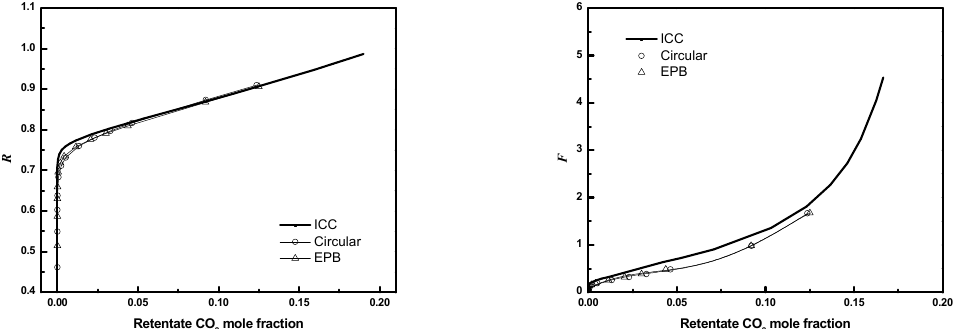
Figure 19. R or F as a function of CO 2 mole fraction for full 3-D circular module and EPB module ( N = 405, D = R f , φ = 0.6. Circle, circular bundle; up triangle, EPB; solid line, ICC).